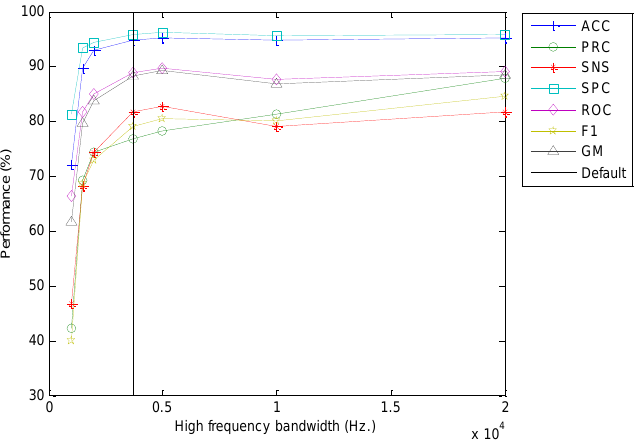
Figure 25. Classification performance metrics of the best classifier vs. the high-frequency limit.